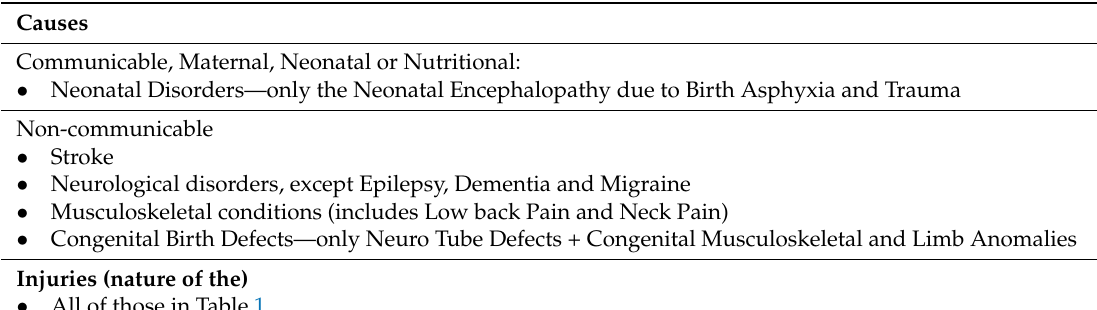
Table 2. Subgroup of health conditions for a separate, highly conservative analysis of physical rehabilitation